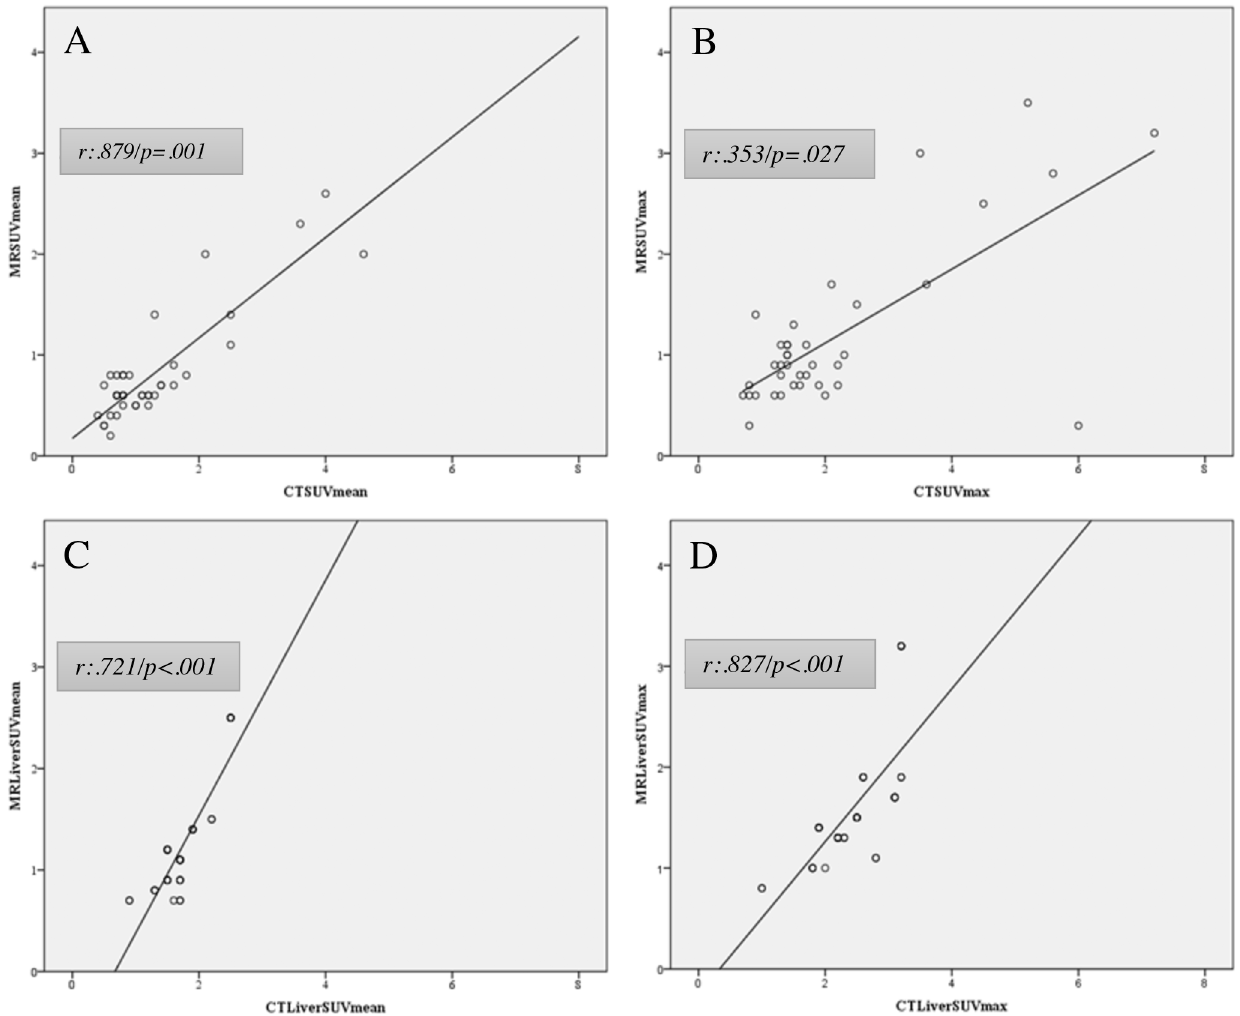
Fig 2. Correlation of the PET component of PET/MRI and PET/CT. (A) SUVmeanshoweda strong positive correlation and (B) SUVmax a moderate positive correlationfor PET/MRI and PET/CT. (C and D) SUV mean and max showeda strong positive correlationfor patient-based liver